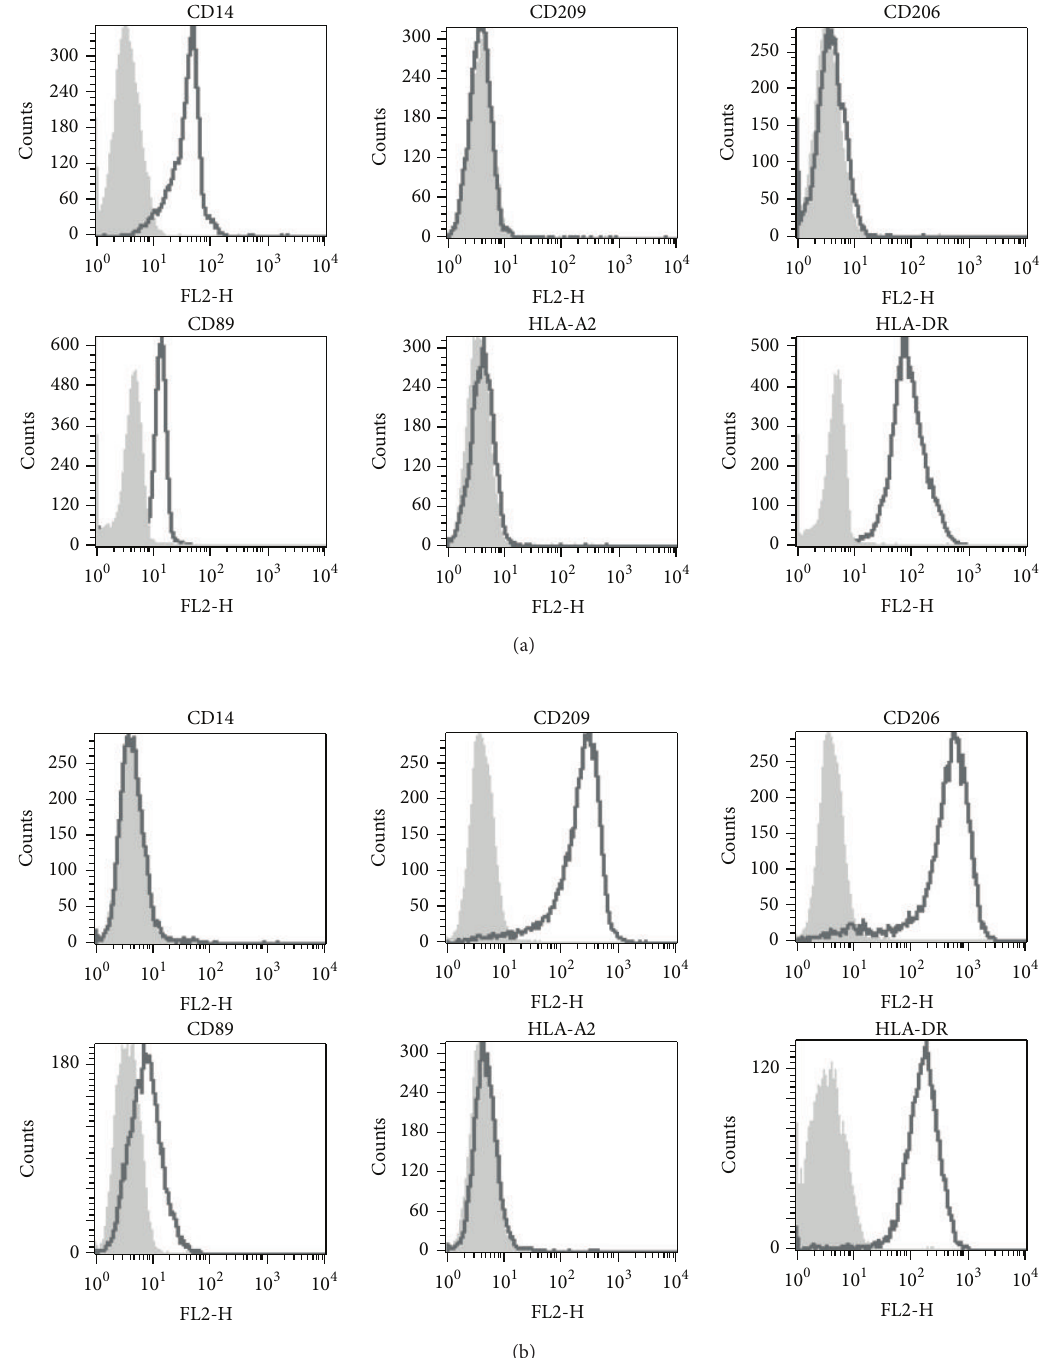
Figure 1: Phenotype and expression of cell surface molecules on monocytes and moDC. Monocytes (a) and moDC (b) were stained with primary antibodies targeting different cell surface molecules. Staining was visualized with goat anti-mouse Ig-F(ab)2-PE. Grey filled histograms depict isotype controls and black bold lined nonfilled histograms depict the